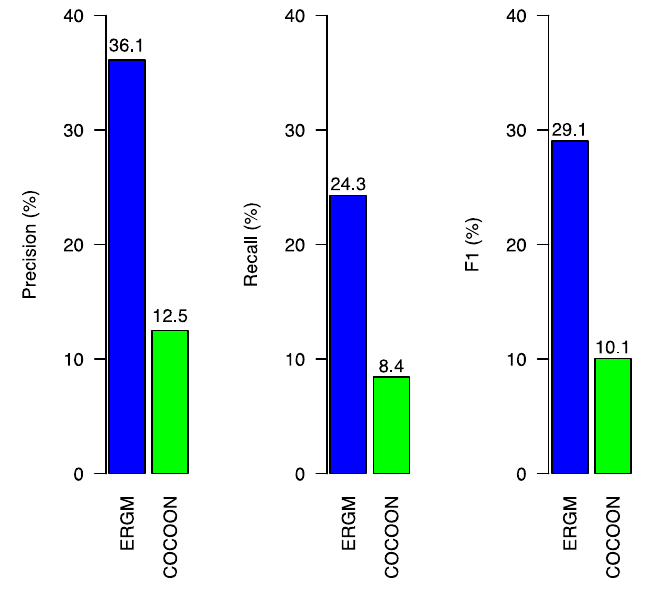
Figure 11. Evaluation results.